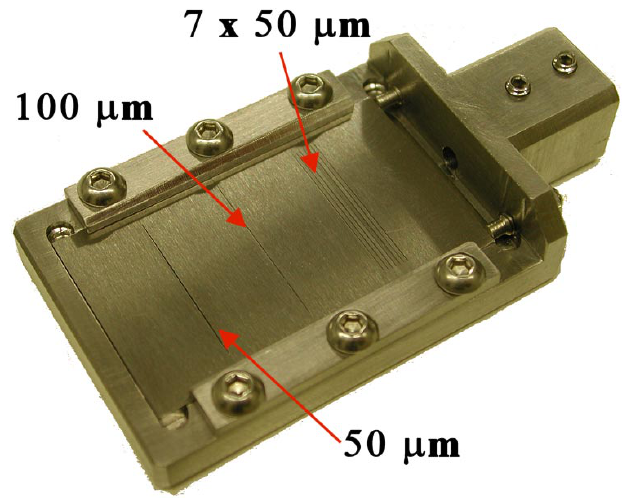
FIG. 6. (Color) Slit mask composed of 7 slits of 50 (cid:1) m width spaced by 500 (cid:1) m , one slit of 100 (cid:1) m width, and one slit of 50 (cid:1) m width.